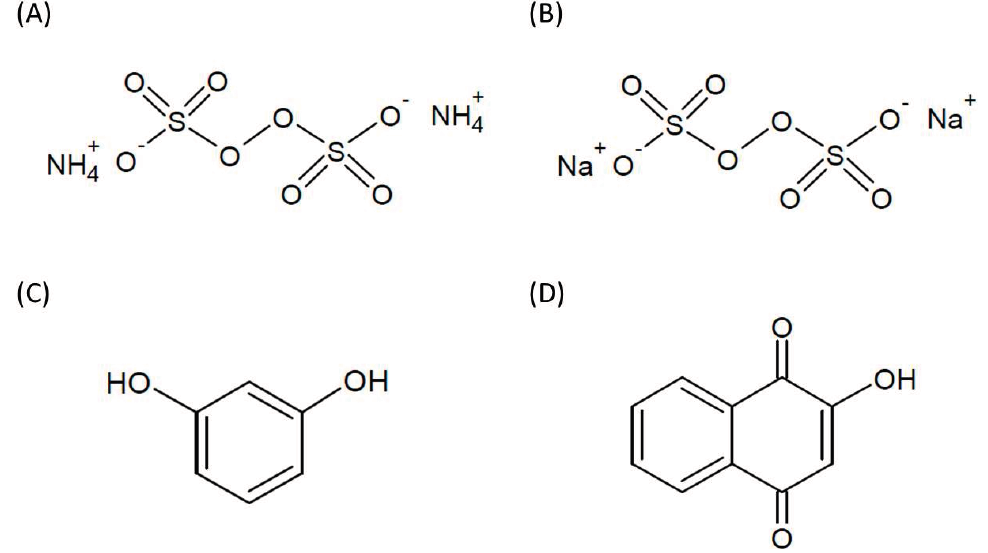
Figure 1. Chemical structures of ( A ) ammonium persulfate; ( B ) sodium persulfate; ( C ) resorcinol and ( D )